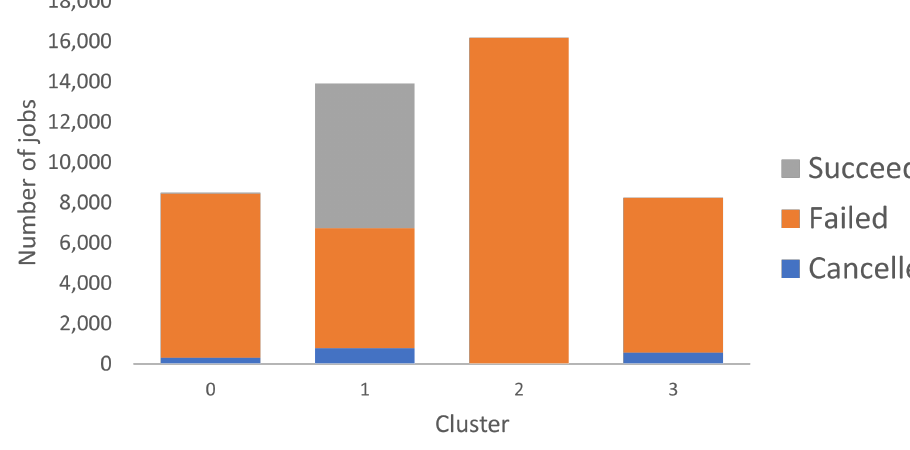
Figure 10. Job status across clusters.